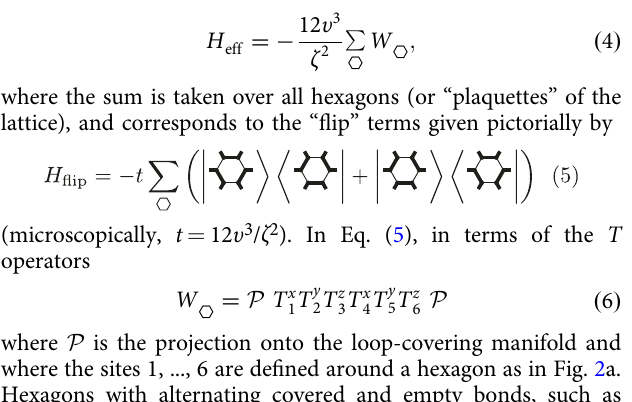
Fig. 5 Variational phase diagram of the S = 1 spin model on the non-uniform honeycomb lattice. a The non-uniform exchange pattern considered, with γ ij γ ij λ ; λ P i bonds forming plaquette and dimer structures, respectively. Note that ∑ γ P γ p d ¼ h P i j p ; d diagram for the non-uniform bilinear-biquadratic model with the exchange pattern depicted in ( a ), in the β − λ p plane, in a simple variational approach. AFM denotes the simple S = 1 antiferromagnet (red and blue circles represent S z = 1 and S z = − 1 spin), n-VBS denotes a valence bond solid where the valence bonds have nematic symmetry, and the Haldane hexagon loop state is made of a crystal of hexagonal Haldane chains. c λ p (shown in a ) as a function of V / t as obtained from ref. 38 . The labeling and coloring of the phases is given in the simplest case β ≲